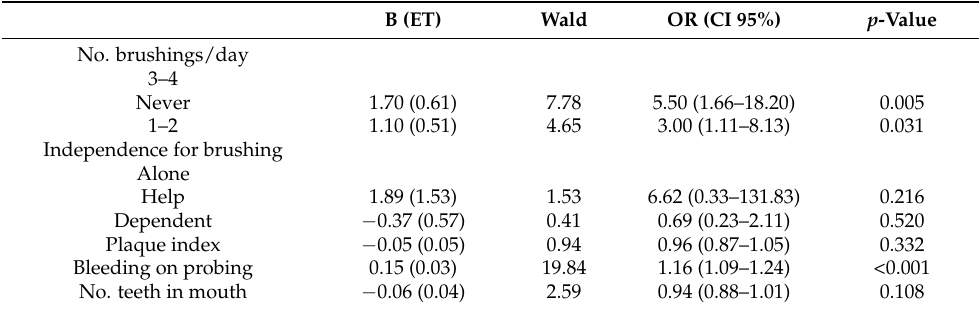
Table 5. Effect of the factors related to oral cavity conditions in the prognosis of